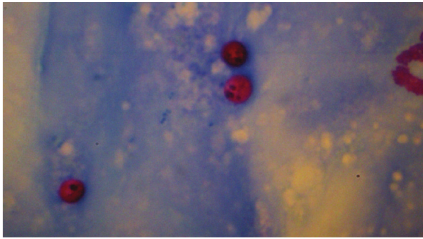
Figure 4: Cryptosporidium oocysts on modified acid-fast stain, under oil immersion.